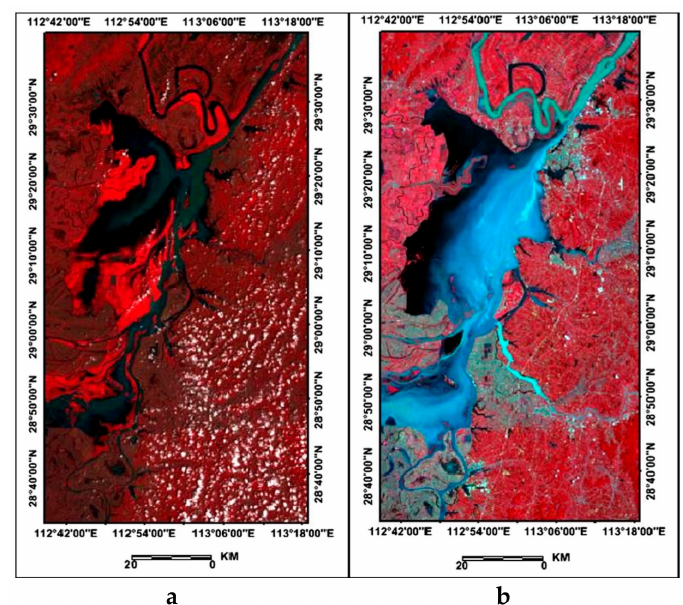
Figure 2. False natural colour composite (R: SWIR, G: NIR, B: Green) pre- and post-flooding Landsat 8